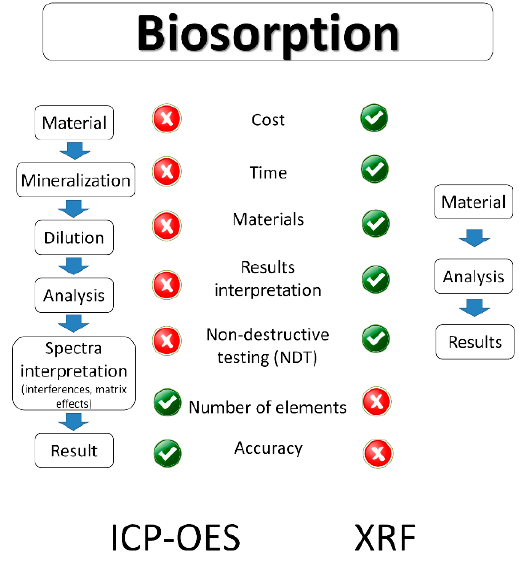
Figure 2. Advantages and disadvantages of ICP-OES and XRF in biosorption studies.